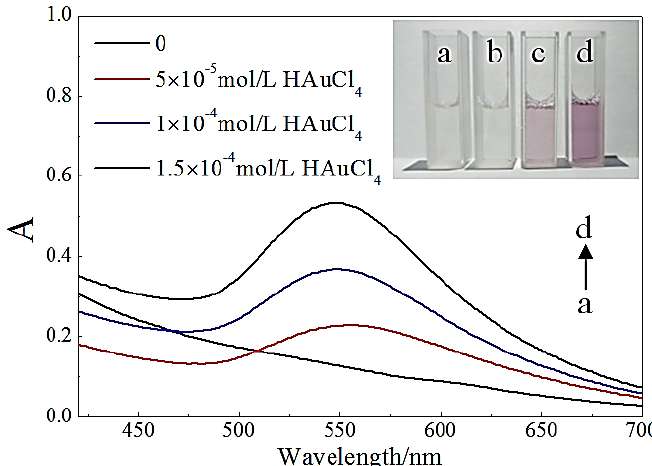
Figure 1. UV–Vis spectroscopy of gold nanoparticles (AuNPs) generated in situ by particulate methane monooxygenase (pMMO)-enriched membrane fraction mediation. The inset shows the different colors with respect to HAuCl 4 amount.